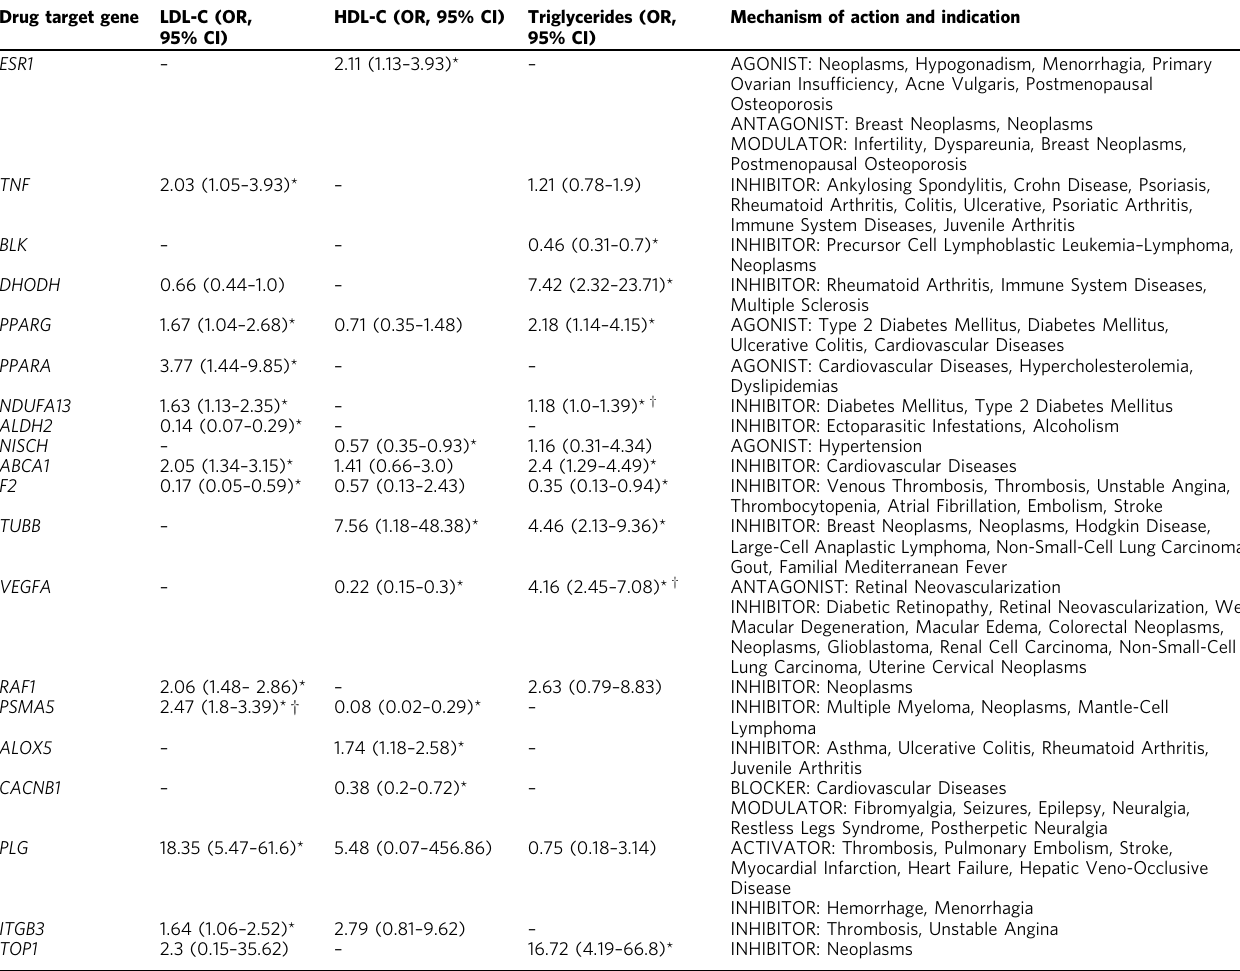
Table 1 Univariable drug target MR estimates for drug targets approved for indications other than lipid-lowering. Drug target gene LDL-C (OR, 95%